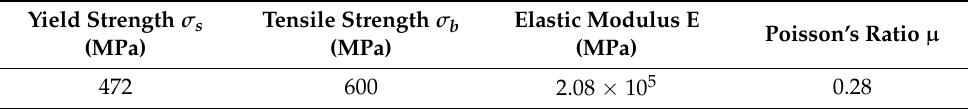
Table 4. Mechanical properties of welding wire ER50-6.